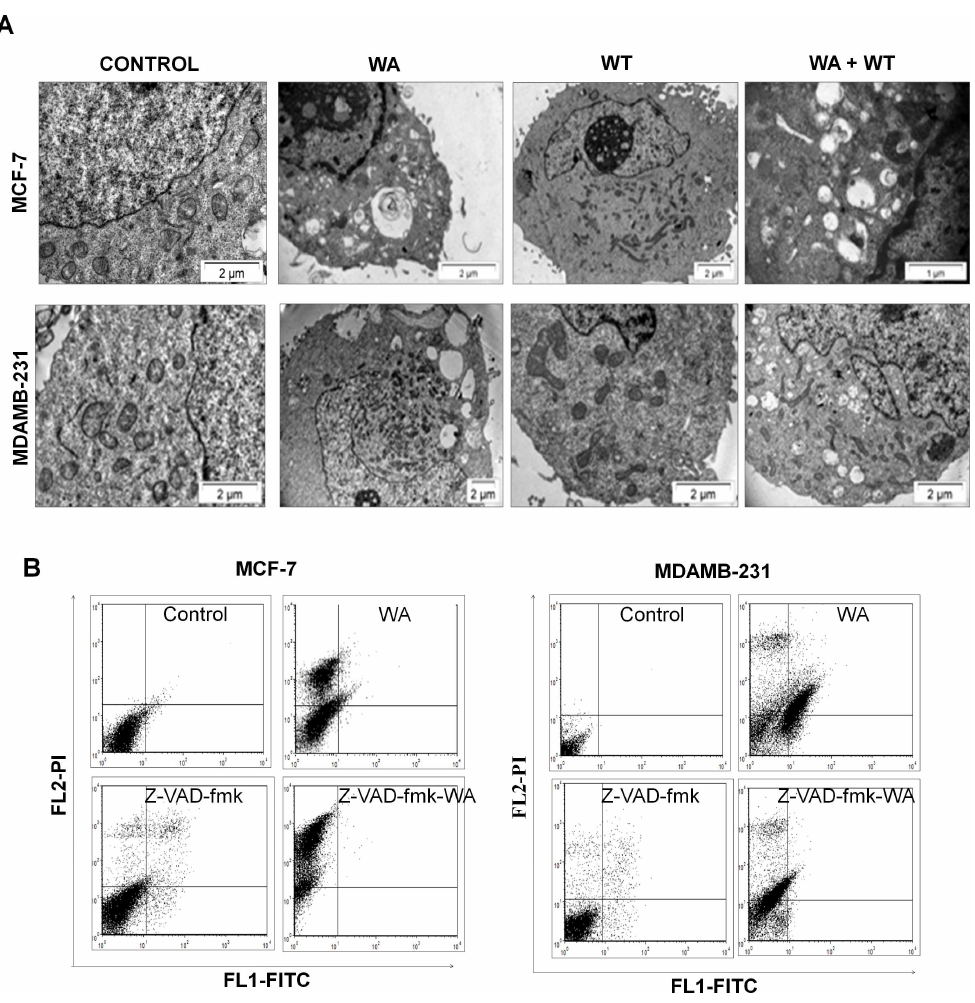
Fig 3. Effect of autophagy and apoptosis inhibitors on WA mediated cell death. (A) Transmission electron micrographs of MCF-7 and MDA-MB-231 cells, treated with either DMSO or WA (4 μ M) in presenceand absence of autophagy inhibitorWT for 24h. (B) For apoptosisassay both MCF-7 and MDA-MB-231 cells were either treated with DMSO, WA (4 μ M) or pre-treatedwith zVAD-fmk in presenceor absenceof WA (4 μ M). Cells were harvestedafter 24h exposureand stainedwith annexinV-FITC and PI. The sampleswere analysedusing flow cytometer. The percentage of earlyapoptotic, late apoptotic and necrotic cells was locatedin the lower right (annexinV-FITC positive/PI negativecells), upper right (annexinV-FITC positive/PI positive cells) and upper left (PI positive cells)